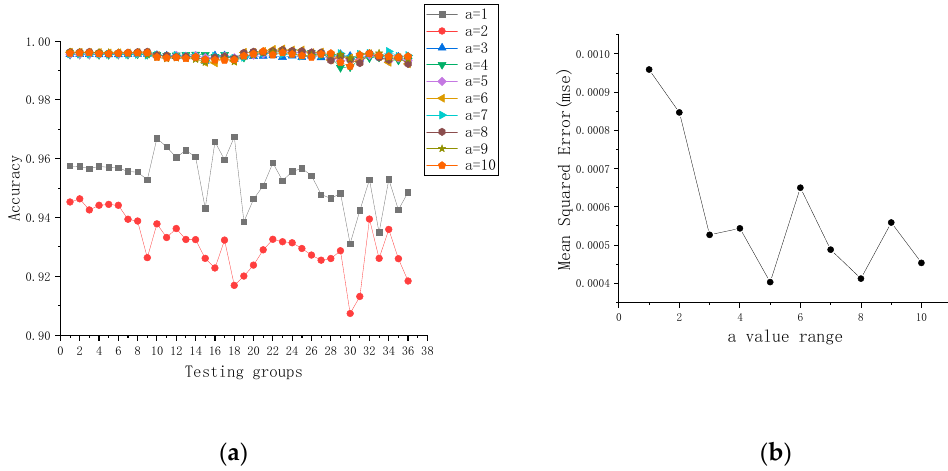
Figure 5. A value assessment. ( a ) Accuracy at different output values; ( b ) MSE at different model fit to data.